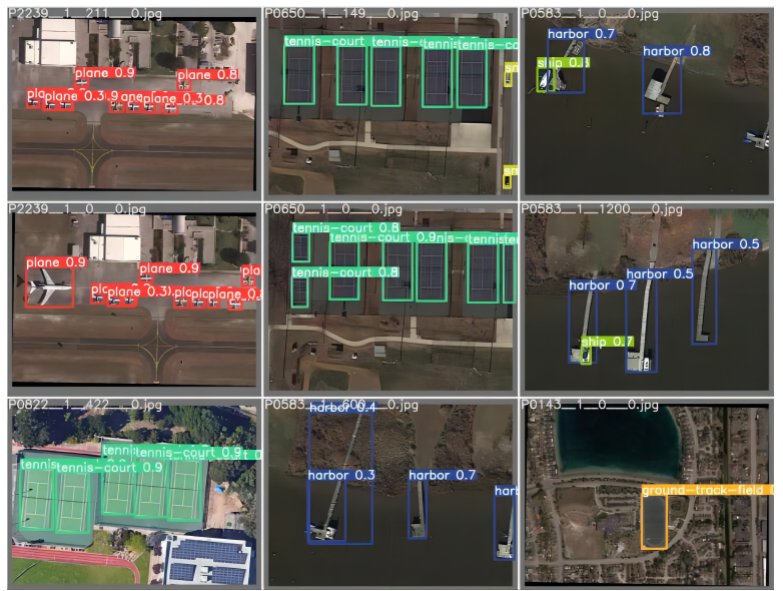
Figure 8. Results predicted by MDCT on DOTA, which includes the plane, tennis court, harbor, and ground track field.